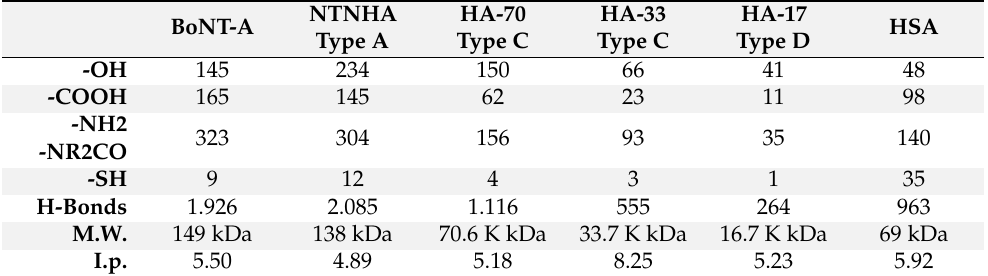
Table 5. Biochemical features of the proteins diluted in the various solutions analyzed.